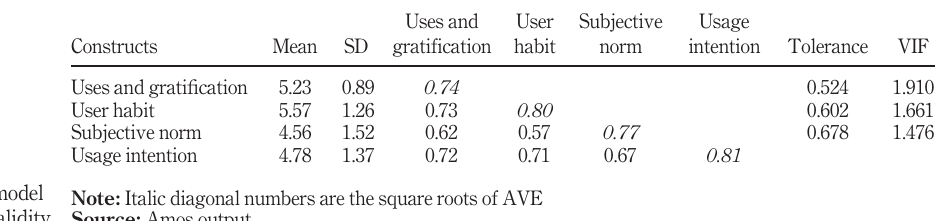
Table VII. Higher-order measurement model discriminant validity